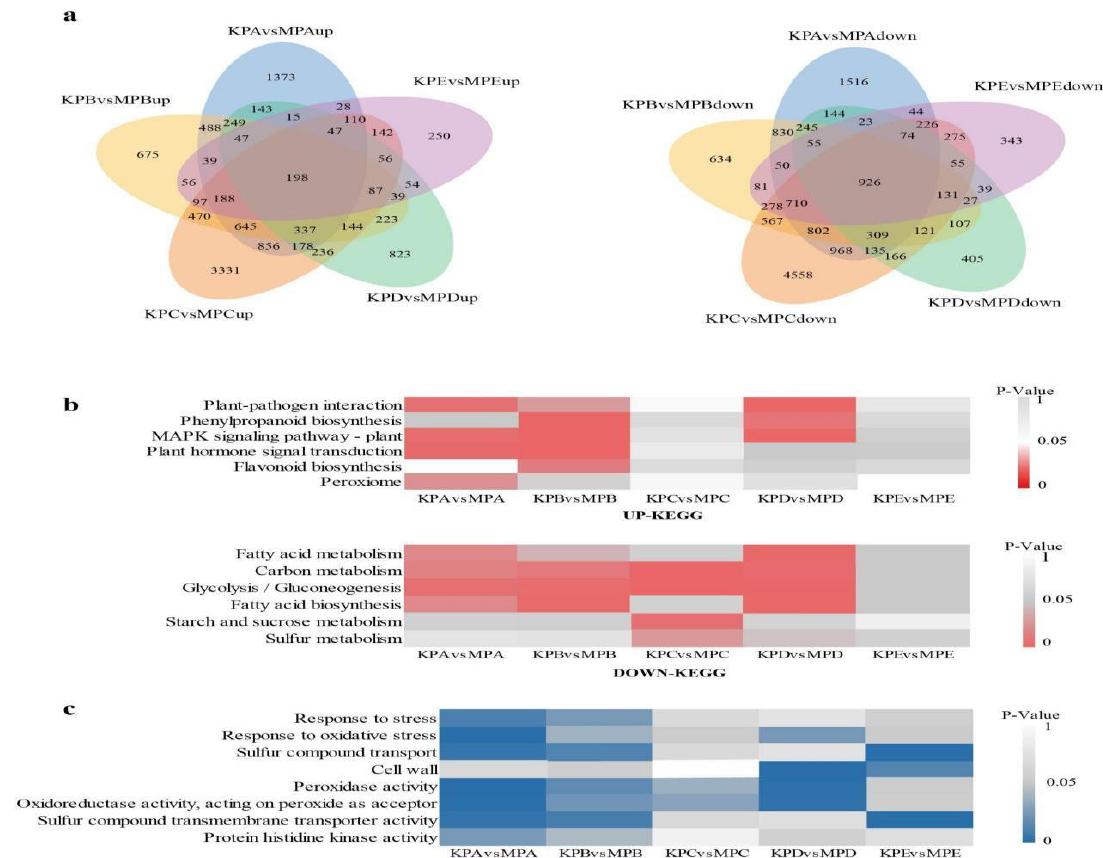
Figure 8. Analysis of the functional enrichment of the DEGs between HZ2399 and SQ25. ( a ) Venn diagrams of all time points exhibiting up- or downregulated expression between HZ2399 and SQ25. ( b ) Results of the KEGG pathway enrichment analysis of the DEGs between HZ2399 and SQ25. ( c ) Results of the GO enrichment analysis of the upDEGs between HZ2399 and SQ25.